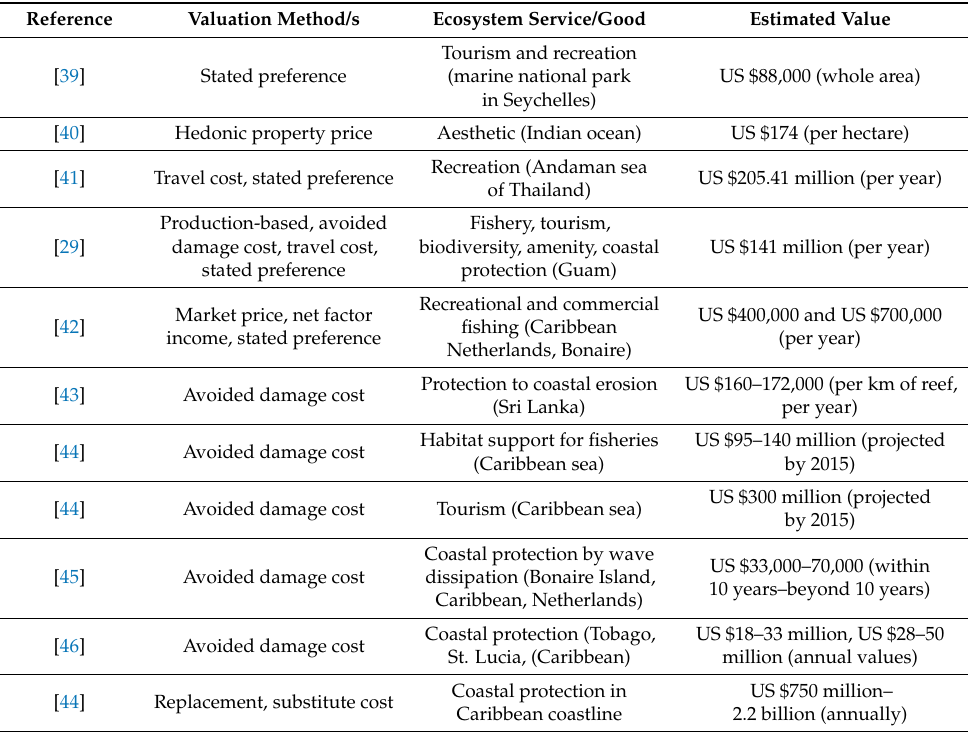
Table 4. Selected applications of valuation of coral reef ecosystem